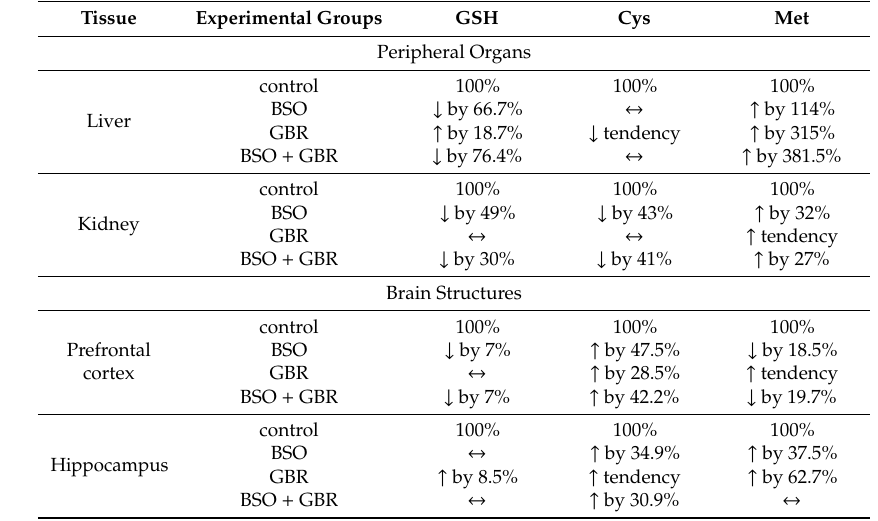
100% ↔ ↓ tendency ↔ 100% ↓ by 43% ↔ ↓ by 41% 100% ↑ by 47.5% ↑ by 28.5% ↑ by 42.2% 100% ↑ by 34.9% ↑ tendency ↑ by 30.9%